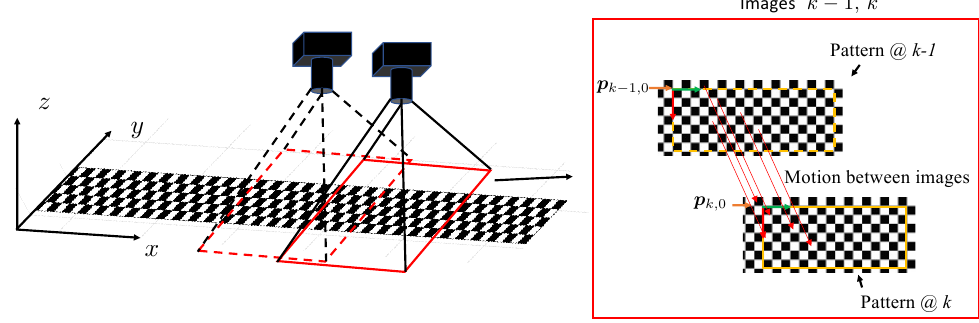
Figure 3. Scheme for downward camera localization.